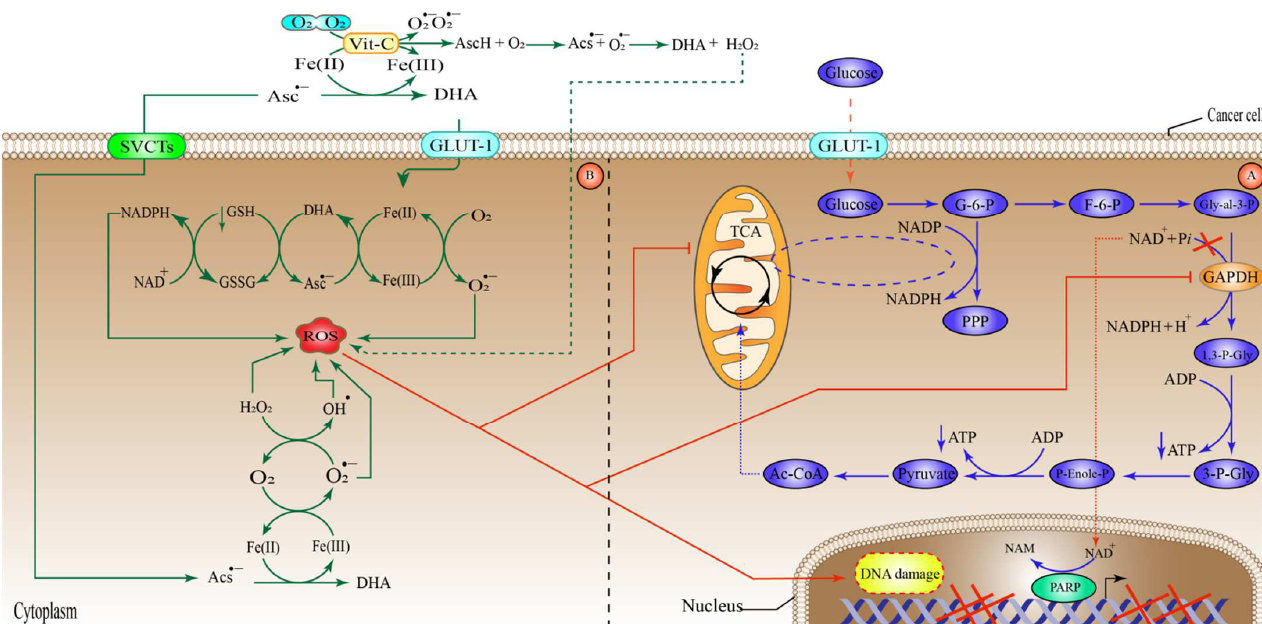
Figure 2. The anti-glycolytic and apoptotic effect of high-dose vitamin-C on tumor cell toxicity. High-dose Vit-C can destroy cancer cells by utilizing two different pathways that work in tandem. Initially, by producing hydroxyl radical (OH • ) through the Fenton reaction, extracellular H 2 O 2 may effectively kill cancer cells [102]. High amounts of Fe (III) ions in the cancer microenvironment promote the oxidation of Vit-C from the ascorbate radical to DHA and Fe (II). After the generation of Fe(II), the ion enters an oxidation process via O 2 , resulting in the formation of superoxide (O 2•− ), which will be consequently converted to H 2 O 2 and O 2 by superoxide dismutase (SOD). Transferrin in the extracellular space traps Fe (III) and binds to the TfR receptor, and oxidizes the Fe(III) to Fe(II), resulting in the formation of LIP inside the tumor cell. The generated extracellular H 2 O 2 can also diffuse directly inside tumor cells via aquaporins [46], interacting with Fe(II) to form OH • , which is hazardous to cancer cells. Then, ascorbate and the ascorbate radical recycle Fe(III) to Fe(II), to form DHA, with the generation of intercellular ROS leading to cell death by apoptosis. Second, the extracellular oxidation process of ascorbate to DHA in large quantities results in DHA uptake by glucose transporter 1 (GLUT-1). DHA is then reduced by glutathione (GSH) and NADPH to high amounts of intercellular ROS, activating poly(ADP-ribose) polymerase (PARP), which in turn consumes cellular NAD + , a co-factor of GADPH. As a result of the inhibition of GADPH, ATP production via glycolysis stops, leading to energy crisis [46]. In addition, the intercellular ROS generated by DHA oxidation can raise the metabolites and enzymatic activity in the pentose phosphate pathway (PPP), block the tri-carboxylic acid (TCA) cycle, and increase oxygen uptake, disrupting intracellular metabolic balance and resulting in irreversible cell death, due to an energy crisis. G6P, glucose-6-phosphate; farctose-6-phosphate, F-6-P; Gly-al-3P, glyceraldehyde 3-phosphate; GSSG, glutathione disulfide; SVCT, sodium-dependent vitamin C transporters, ROS, reactive oxygen species; PPP, pentose phosphate pathway; 1,3-P-gly,1,3-phosphglycerate; 3-P-gly, 3-phosphglycerate; P-Enole-P, phospo enol pyruvate; Ac-Coa, acetyl coenzyme A; GADPH, glyceraldehyde 3-phosphate dehydrogenase.